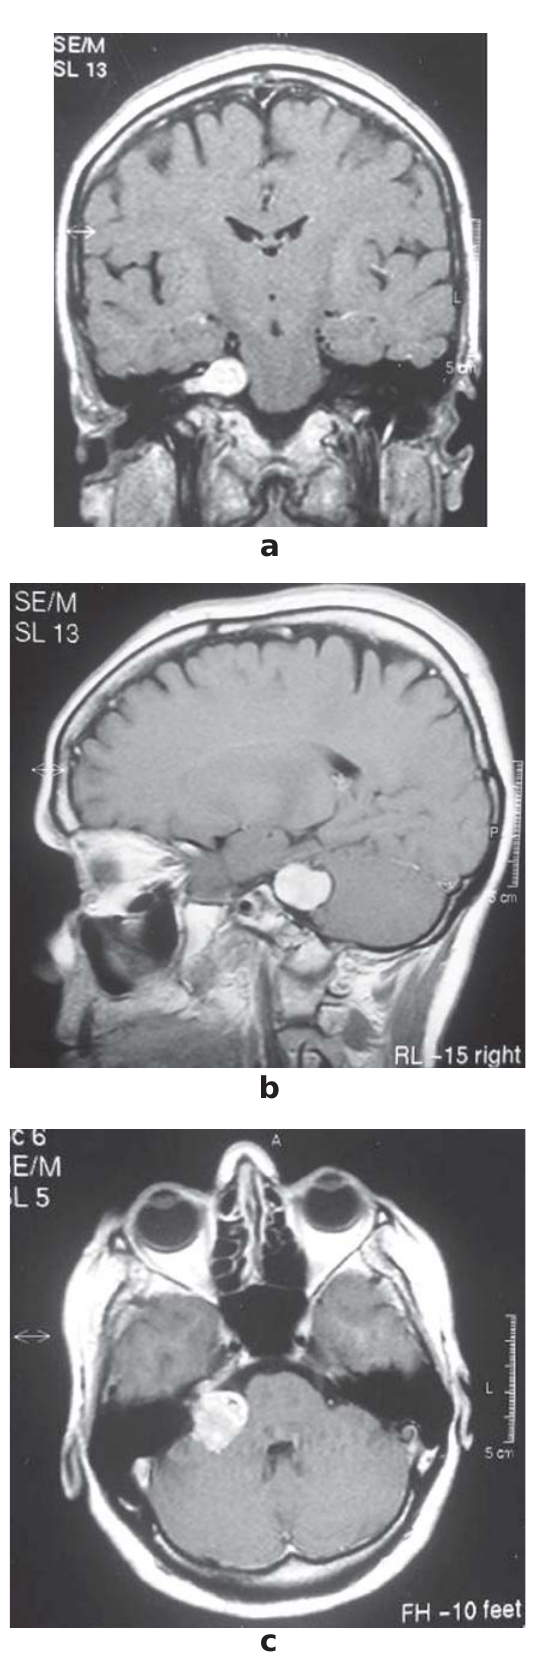
FIGURES 1a, 1b, 1c- Frontal, sagittal and horizontal view (arrows) of an vestibular schwannoma (vestibular schwannoma) of the eight cranial nerve in the internal auditory